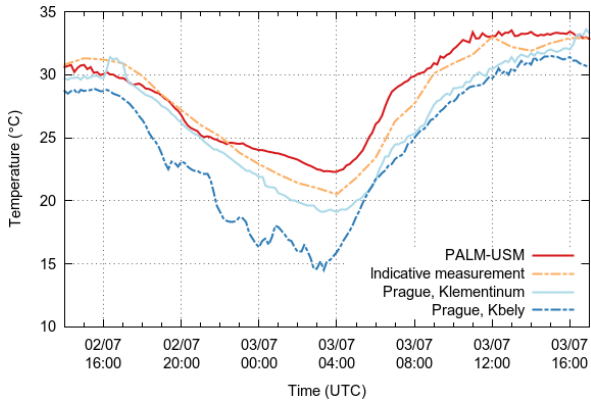
Figure 6. Air temperatures obtained from PALM-USM for loca- tion 1 in comparison to measured